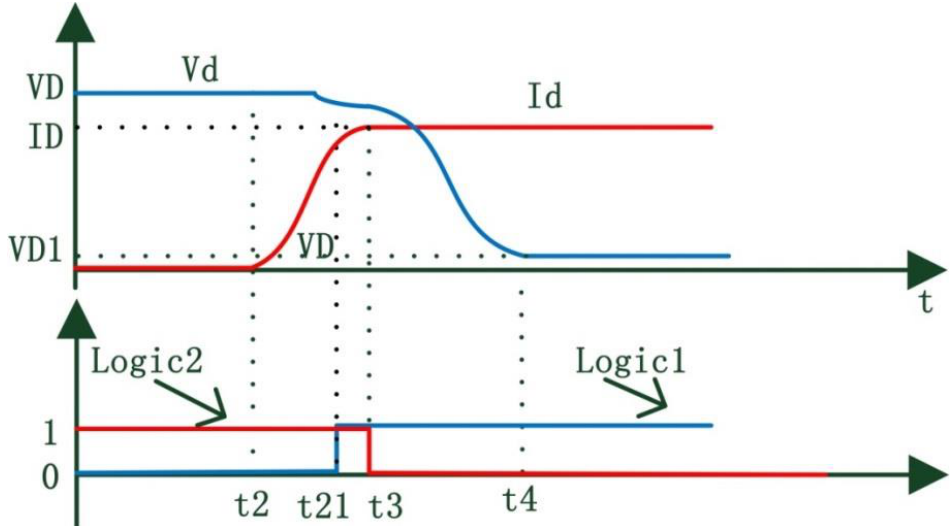
Figure 7. Turn-on voltage and current waveform of SiC MOSFET the in the proposed circuit.